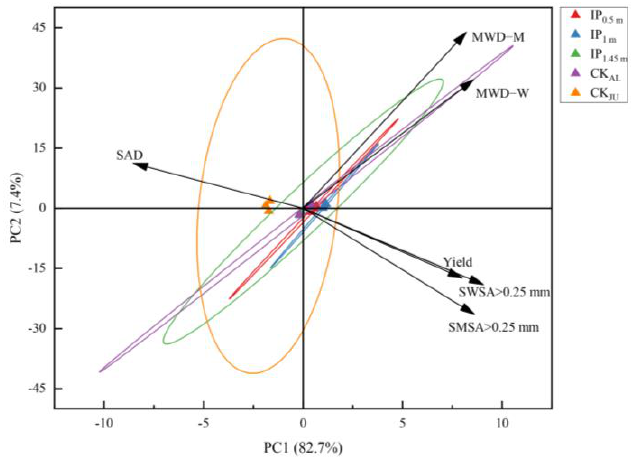
Figure 10. Principal component analysis of soil aggregate parameters and alfalfa yield in alfalfa-jujube tree intercropping systems. Mean weight diameter of soil mechanically stable aggregates (MWD-M); mean weight diameter of soil water-stable aggregates (MWD-W); soil aggregate destruction rate (SAD); mechanically stable soil macro-aggregates (SWSA > 0.25 mm); water-stable soil macro-aggregates (SMSA > 0.25 mm).